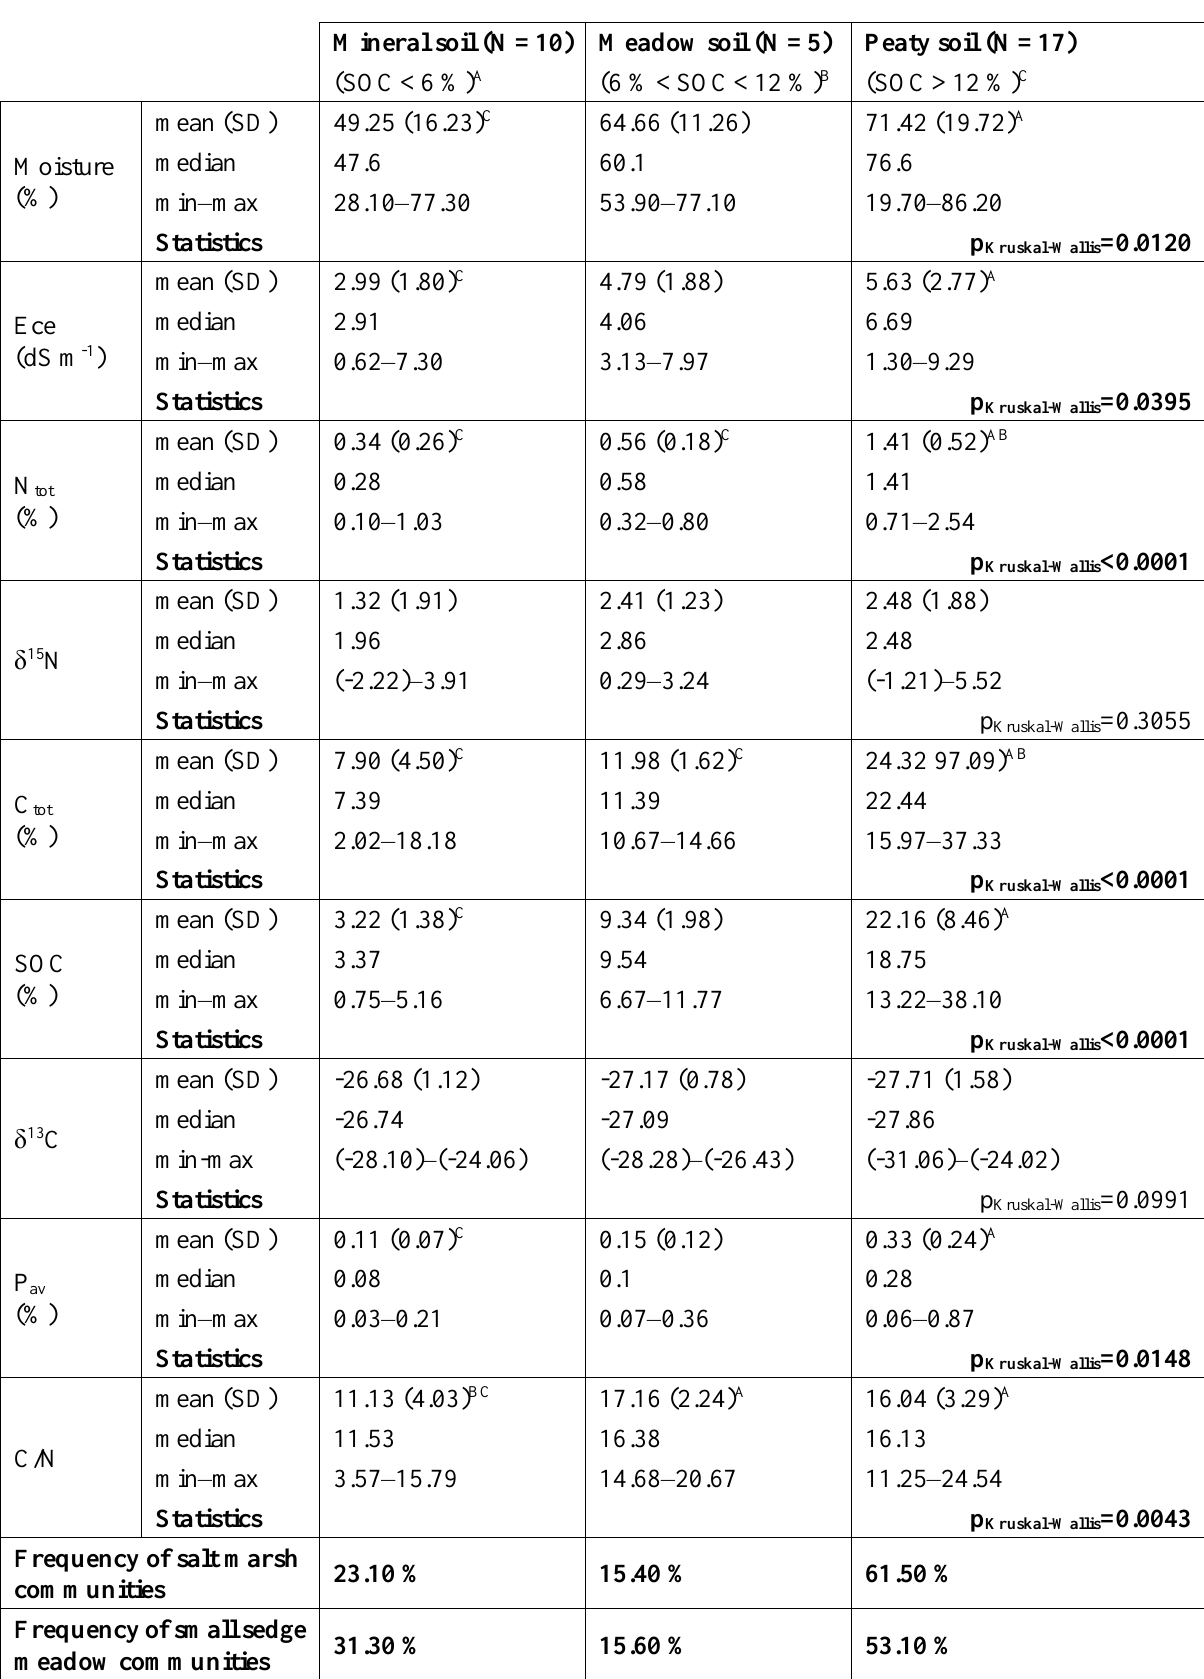
Table A2. Chemical characteristics of the soil types associated with the three plant communities studied. Mineral soil (N =